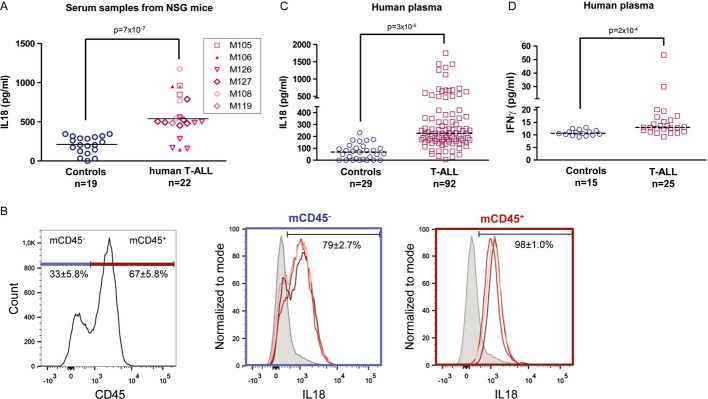
IL-18 production is increased in xenografted mice and in leukaemic patientsA Circulating IL-18 expression levels in NSG mice injected with the indicated T-ALL samples (controls are non-transplanted 8- to 12-week-old NSG mice). Serum samples were collected at the time of euthanasia (6–12 weeks post-transplant) and IL-18 levels were measured by ELISA. Mann and Whitney non-parametric test was used for statistics.B Detection of IL-18 expression in BM from a tumour-free NSG mice. Medullary cells were recovered after flushing and crushing bones. Detection of IL-18 expression was measured by flow cytometry after permeabilization and anti-IL-18 labelling of BM cells.C, D Human IL-18 and IFN-γ levels in plasma samples from paediatric patients with T-ALL (IL-18: n = 92 and IFN-γ: n = 25) and healthy controls (IL-18: n = 29 and IFN-γ: n = 15). Statistical analyses were carried out using Student's t-test (C) or Mann–Whitney non-parametric test (D).